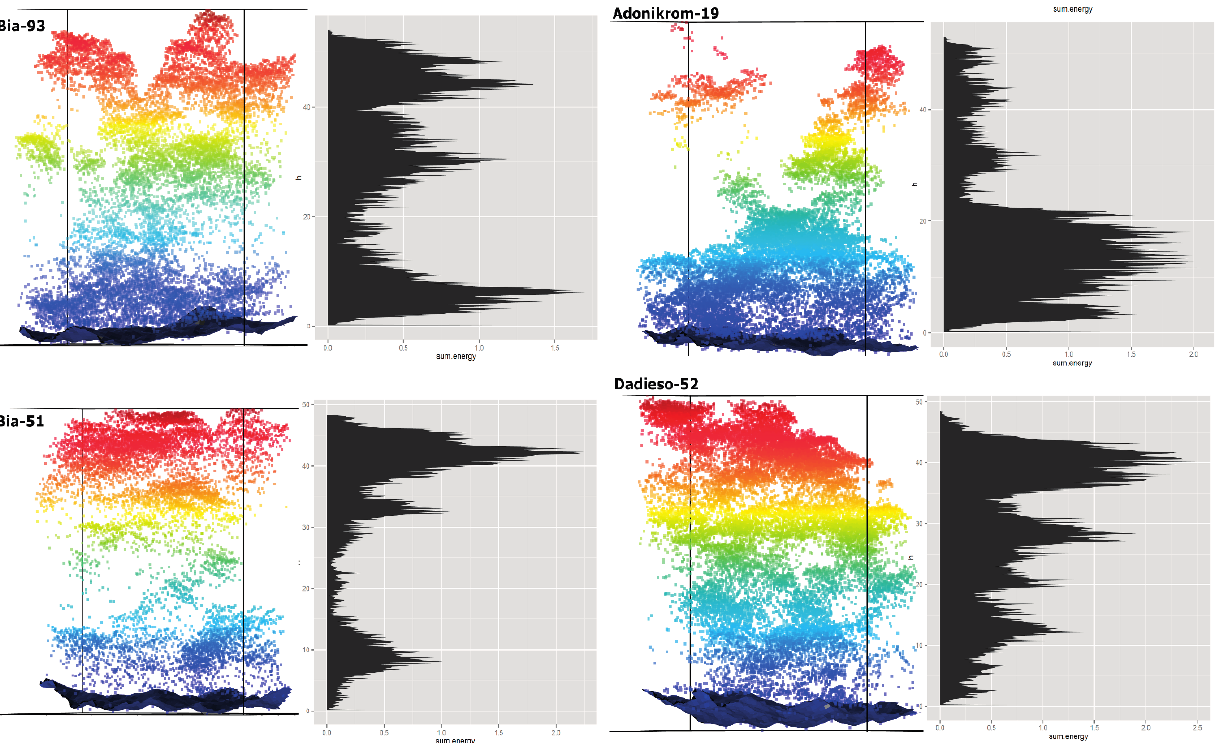
Figure 3. Four 3D representations of echoes and the fitted ground plane of plots, with the height profile of echo energy on the respective